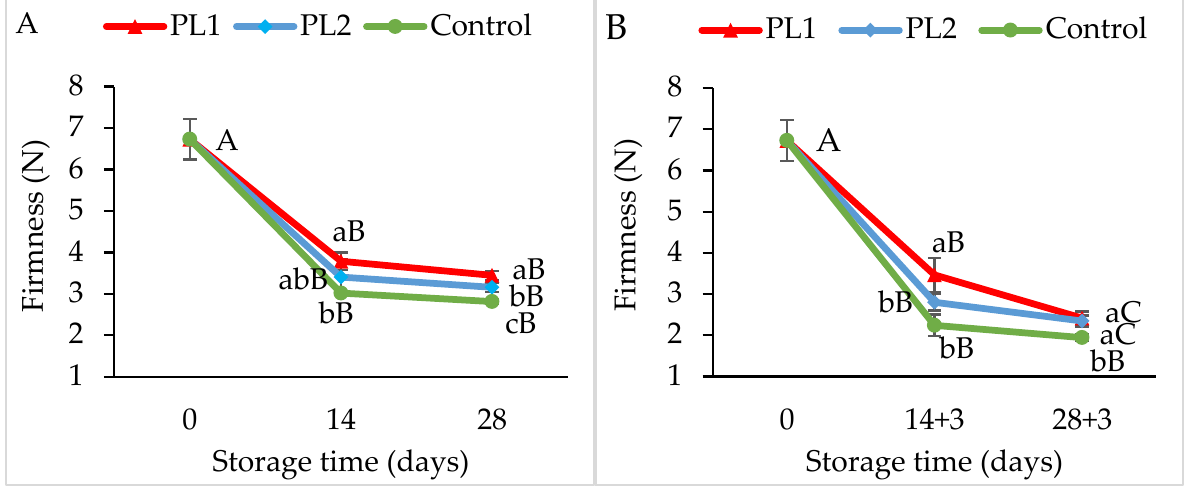
Figure 2. Fruit firmness changes during cold storage ( A ) and shelf life ( B ). Data are the mean ± SE of three replicates of twenty-two fruit. Different uppercase letters indicate significant differences for each atmosphere composition during storage, and different lowercase letters indicate significant differences among atmosphere compositions for each sampling date at p <